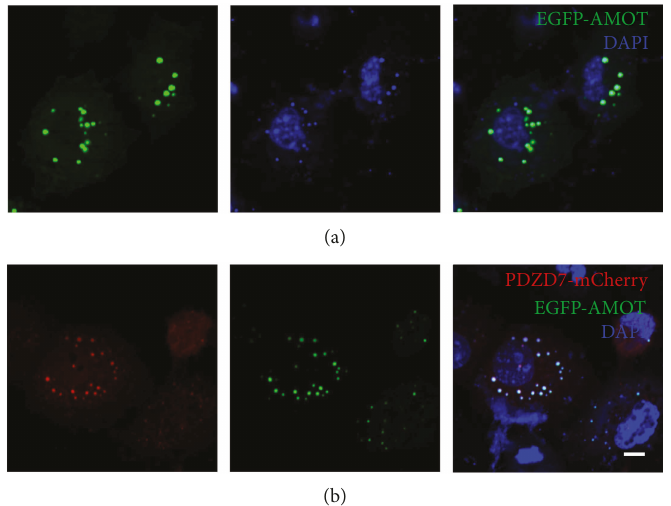
Figure 3: Colocalization of PDZD7 with AMOT in COS-7 cells. Expression vectors were transfected into COS-7 cells, and the subcellular localization of target proteins was determined using confocal microscopy. (a) EGFP-AMOT localized as perinuclear aggregates when expressed alone in COS-7 cells. (b) When expressed together, PDZD7-mCherry colocalized with EGFP-AMOT. Scale bar: 10 μ